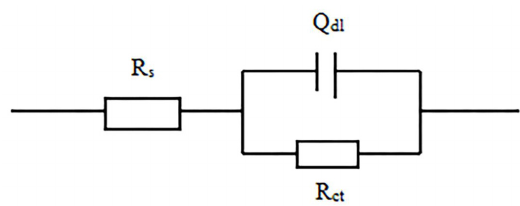
Figure 10. Equivalent Circuit for the impedance